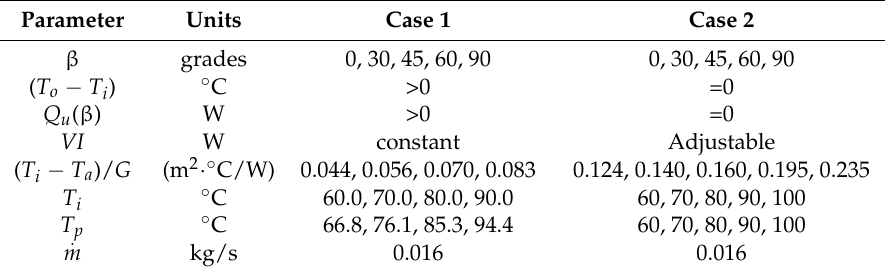
Table 2. Experimental conditions for the two study